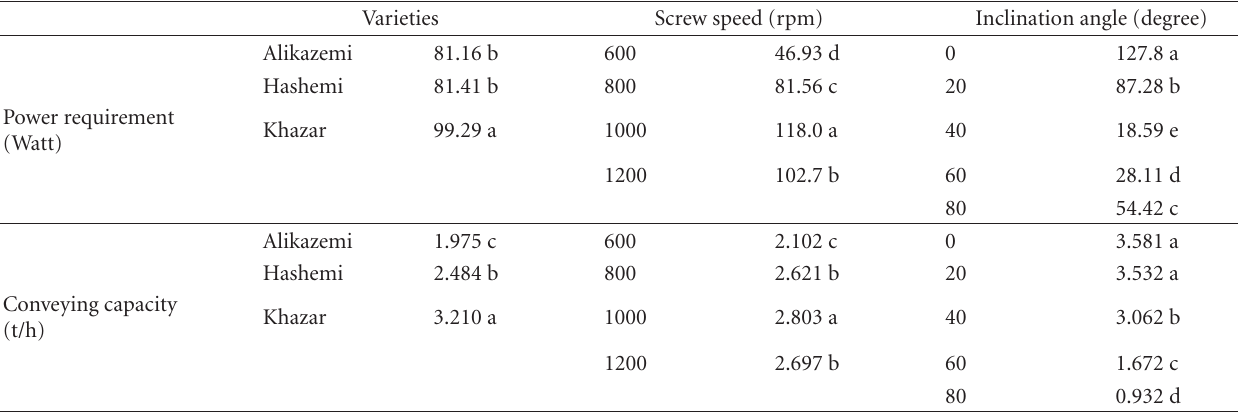
Table 2: The mean comparisons of variety, screw speed, and inclination angle on power requirement and conveying capacity.